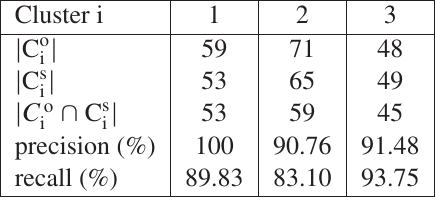
Table 2. Clustering results of our approach on wine